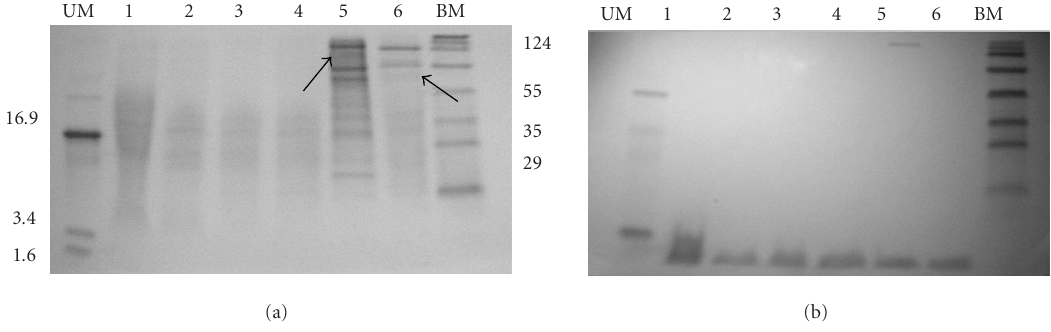
Figure 14. 1-2: Pichia pastoris X-33 clones 1 & 2 at day 3. 3-4: P pastoris KM71H clones at days 5 & 6. 5-6: P pastoris LacZ and P pastoris GS115/HSA (controls). UM represents ultra-low marker (peptides). BM represents broad-range marker (proteins). (a) SDS PAGE gel from supernatant of transformed P pastoris (KM 71H and X-33) and (b) Western blot of supernatant from transformed P pastoris (KM 71H and